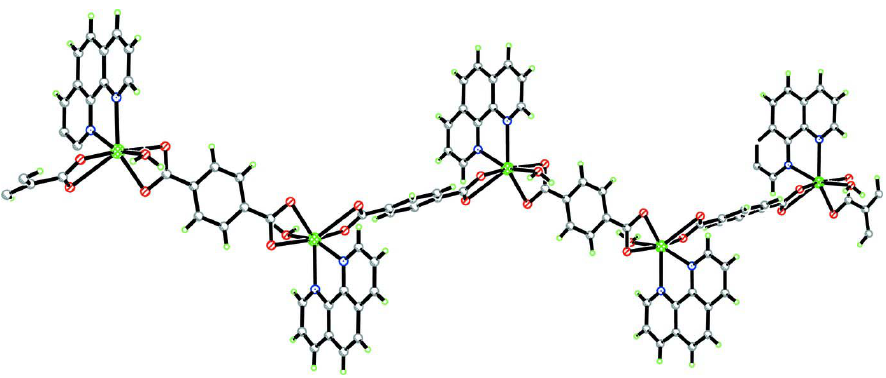
Figure 2 A view of a one-dimensional zigzag chain in the structure of compound (I). The uncoordinated 1,4-benzenedecaboxylic acid solvent molecules were omitted for clarity.